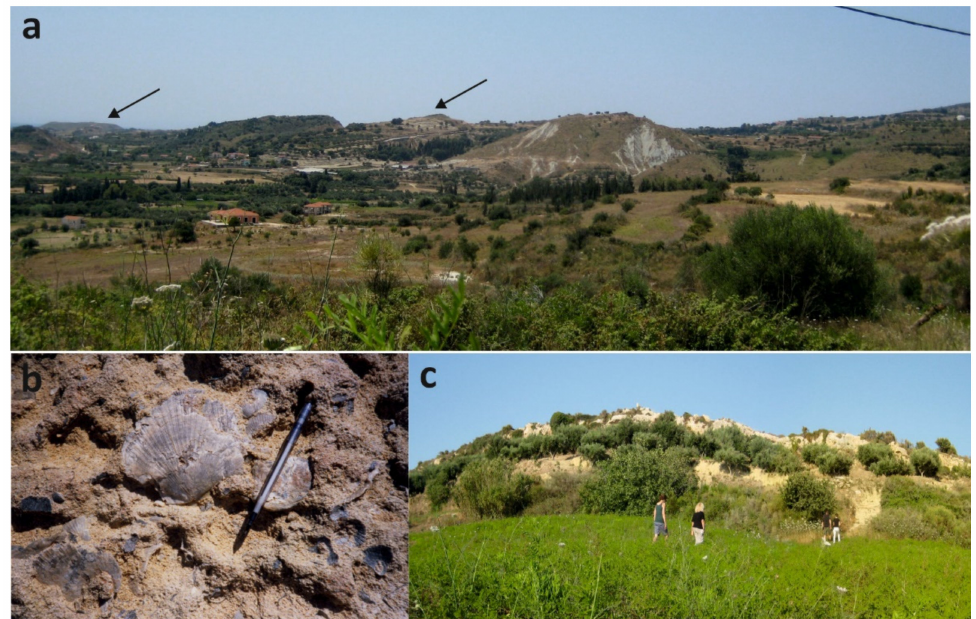
Figure 10. Selected geosites on Kefalonia island, for coding see Figure 4: ( a ) the Pleistocene Paliki marine terraces; ( c ) the youngest of Paliki marine terraces (K15) at Lepeda, with fossiliferous beds rich in Pectinidae ( b ). Photos ( a – c ) courtesy M.V. Triantaphyllou, D.